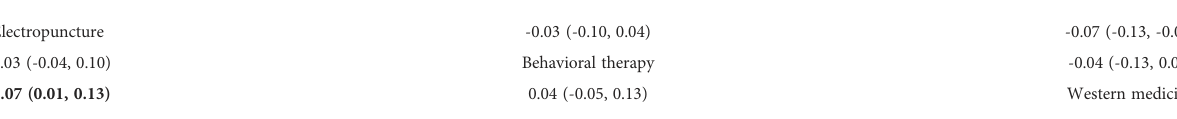
Bold values means the sorting tables represent the area under the curve of the cumulative probability sorting chart, the bold values are the rank of the sorting by different types of intervention in our study. While the number of the ladder table is the relative effect value and 95% CI.